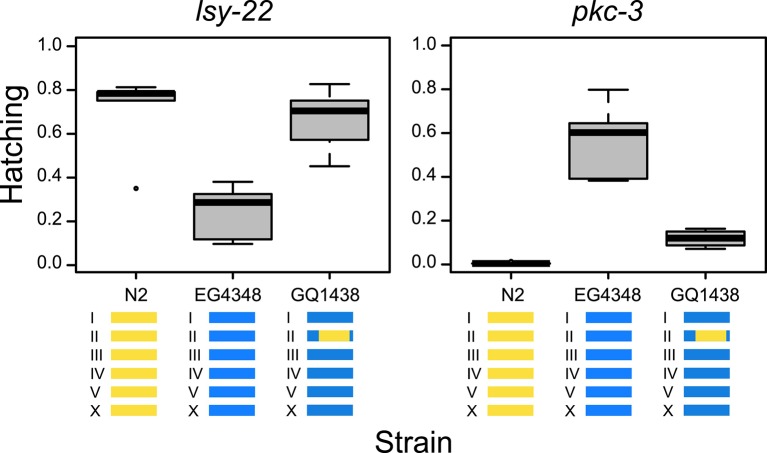
Tests for gene-specific modifiers.Introgression of part of chromosome II from strain N2 (yellow) into
strain EG4348 (blue) rescues the N2 phenotype on lsy-22
(F = 12.15, DF = 2, p = 0.001) and pkc-3 (F = 55.87, DF
= 2, p < 0.001); genome-wide analyses found associations between this
region and hatching phenotypes for both lsy-22 and
pkc-3.DOI:
http://dx.doi.org/10.7554/eLife.09178.00710.7554/eLife.09178.008Figure 3—source data 1.This file provides source data for Figure 3, which reports hatching for
three different strains targeted by RNAi against genes
lsy-22 and pkc-3.It provides counts of dead embryos (emb) or hatched larvae
(larv) on individual agarose-media plates seeded with
bacteria expressing dsRNA for the target genes. In the data
file, the strain QG611 has the N2 genetic background.